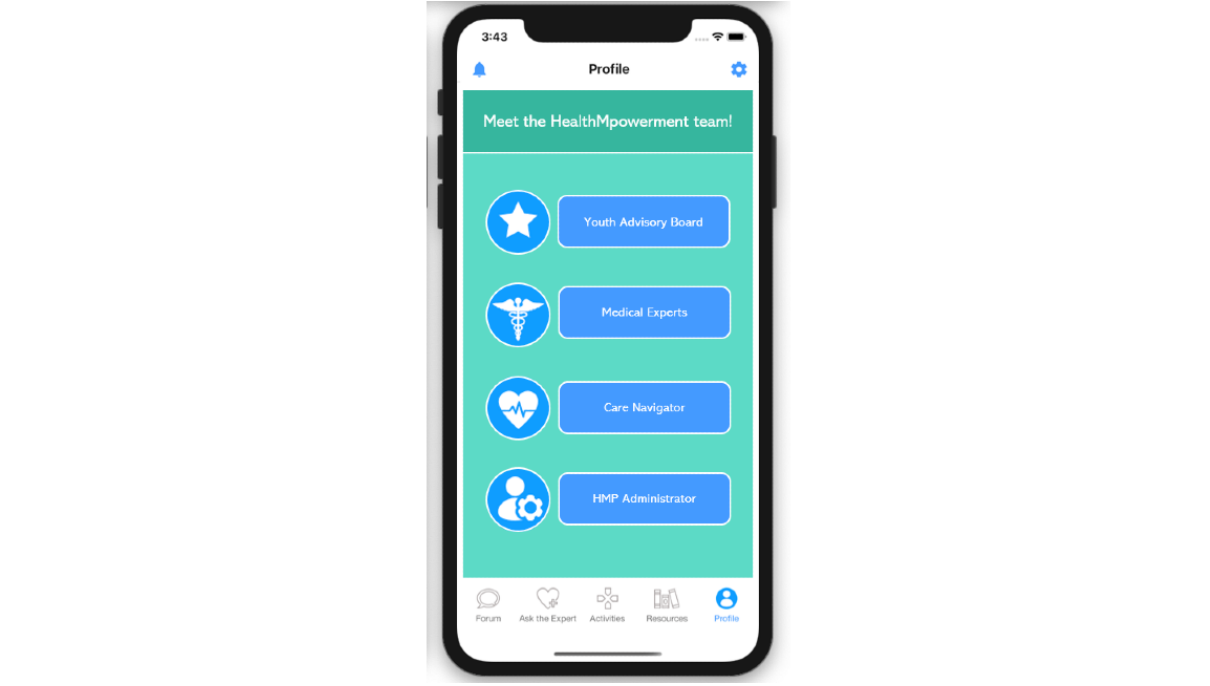
Figure 2. Screenshot of all icons for HealthMpowerment (HMP) 2.0 nonparticipant